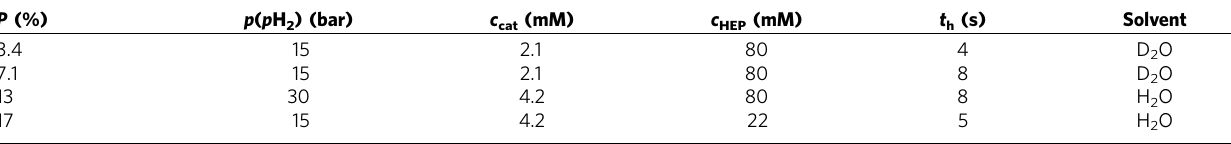
The hyperpolarization of HEP ( 13 C-hydroxyethyl-propionate) at a concentration of c HEP ¼ 80mM was increased by variation of the para- hydrogen pressure ( p ( p H 2 )), the concentrations of the catalyst ( c cat ) and the hydrogenation time ( t h ).